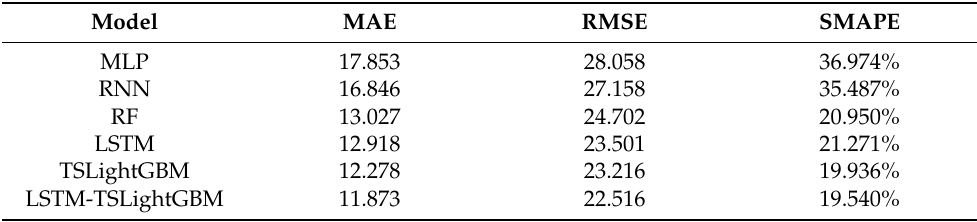
Table 5. The performance of each